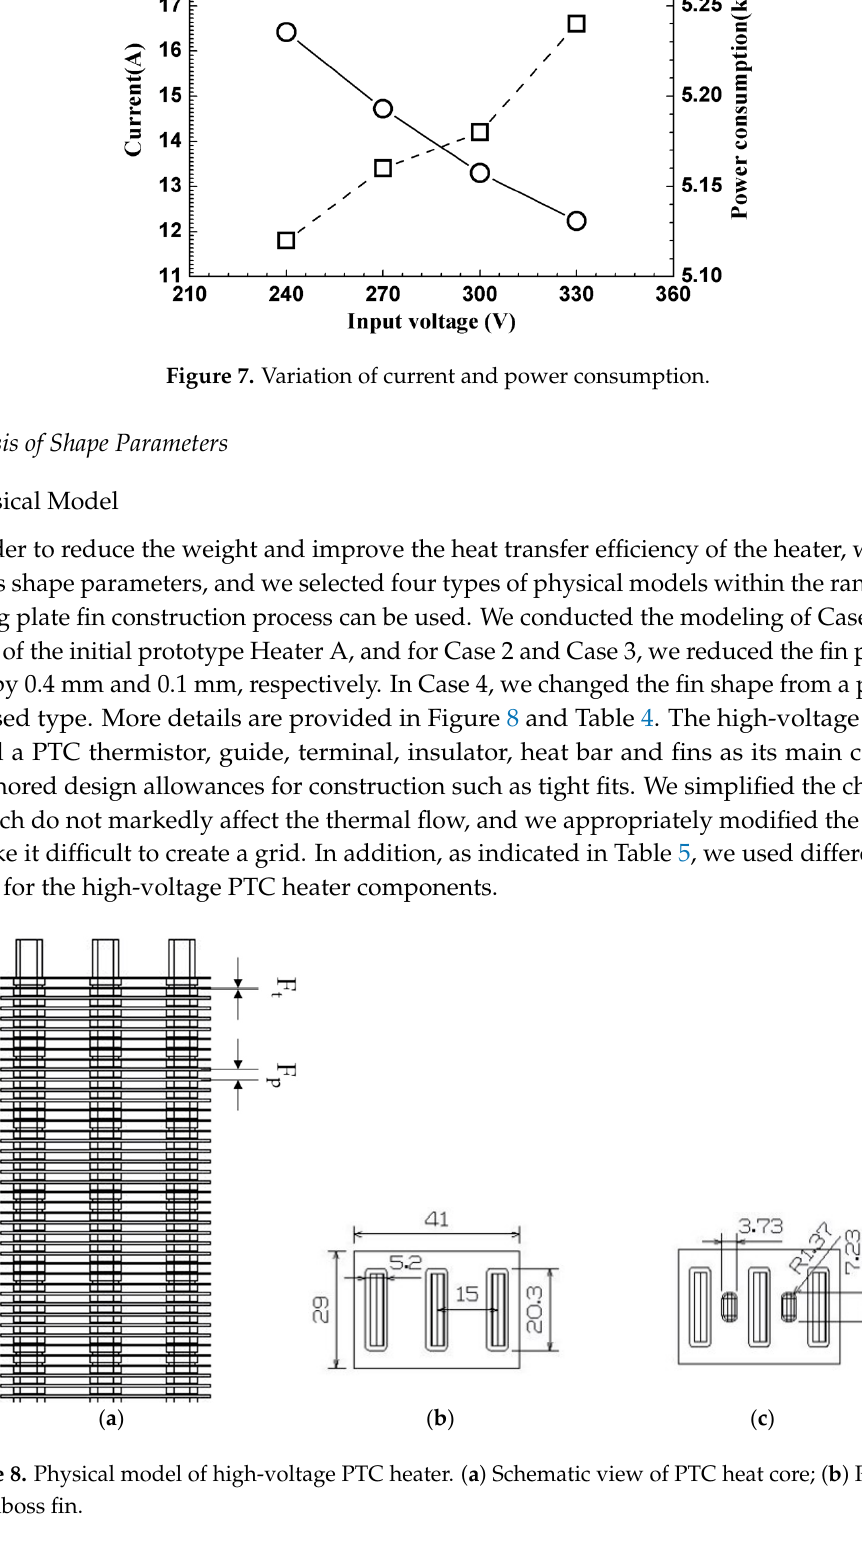
Table 5. Thermal properties of respective parts. Part